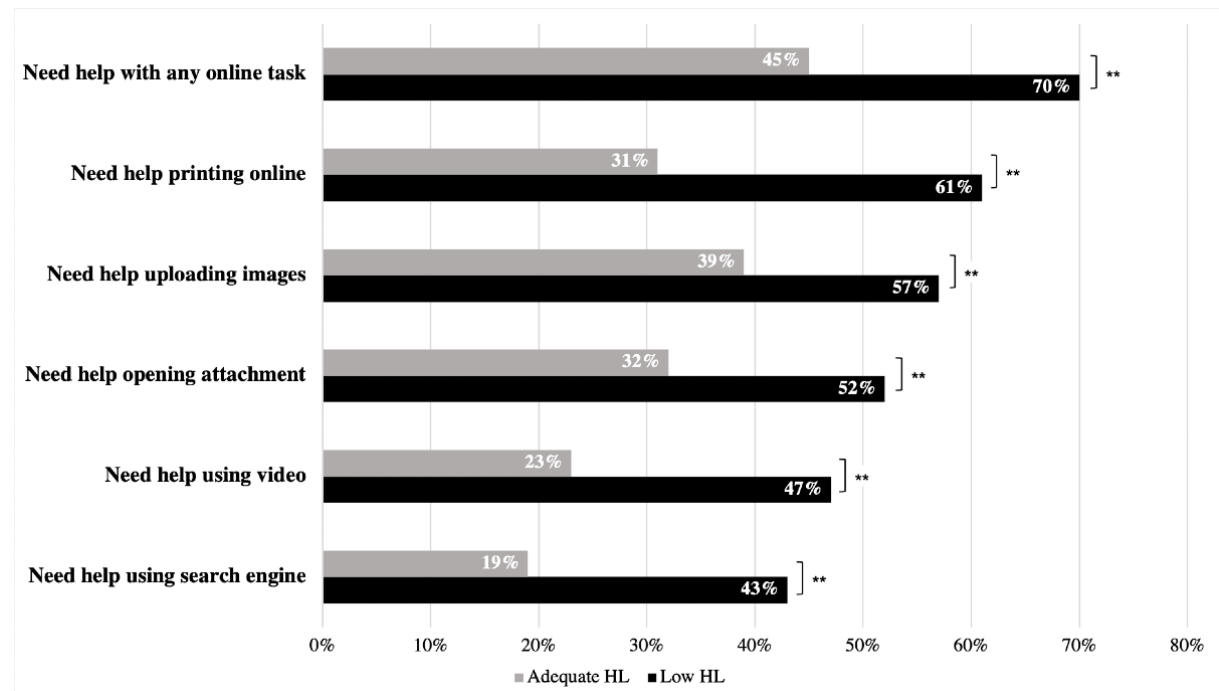
Figure 1. Percent of participants that report needing help with online tasks by health literacy (HL) level. ** demonstrates significance of P <.003 for Bonferroni correction. Raw numbers of participants needing help with each task are as follows: Need help with any online task – adequate HL 135/303 (44.6%), low HL 133/189 (70.4%); Need help printing online – adequate HL 95/303 (31.4%), low HL 116/189 (61.4%); Need help uploading images – adequate HL 119/303 (39.3%), low HL 107/189 (56.6%); Need help opening attachment – adequate HL 96/303 (31.7%), low HL 99/189